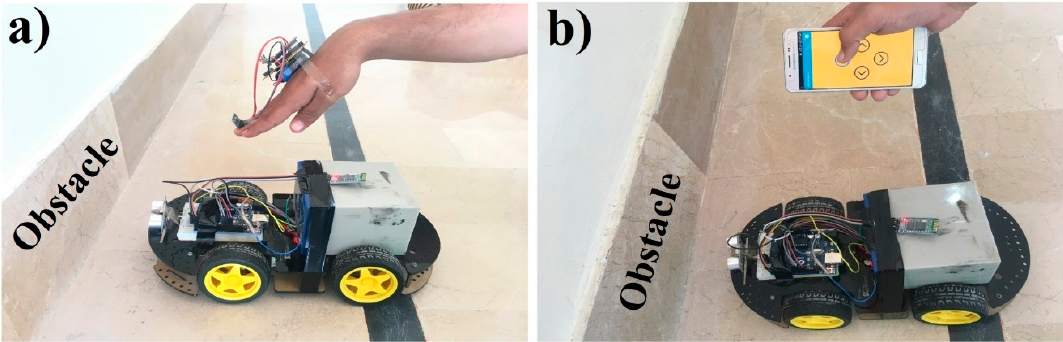
Figure 10. Avoidance of robot car from obstacles using hand-gestures ( a ) and mobile-application ( b ).